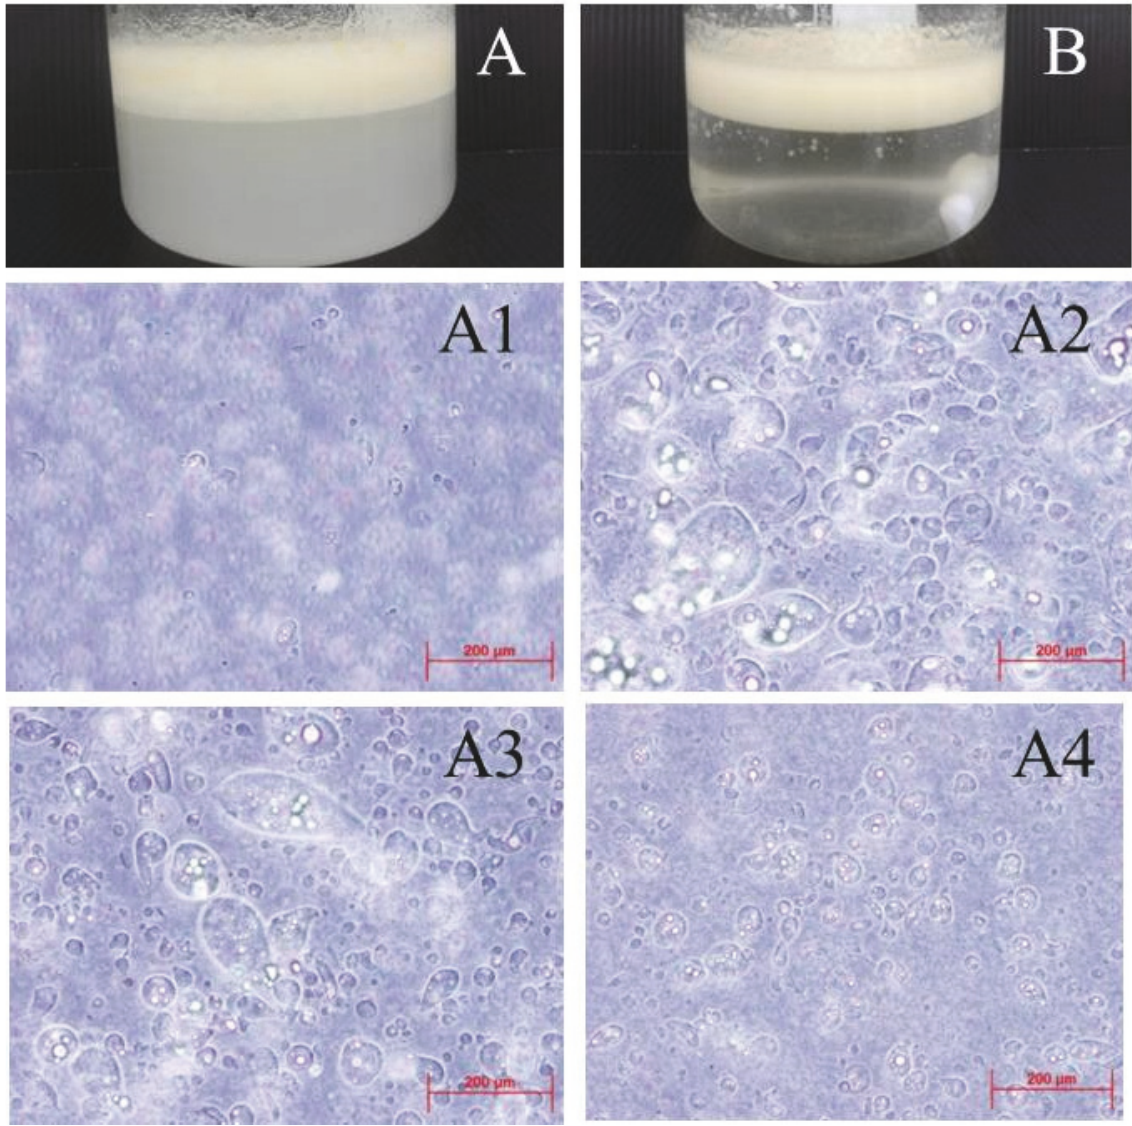
Figure 1: Microencapsulation. Prepared microcapsules with (A) Tween 80 and (B) without surfactant. The emulsion or oil layer is seen in the upperwhiteopaqueareawhilethecalciumchloridesolutionistheclearerareaundertheoillayer.Thepictureshowstheeffectonmicrocapsule morphology under microscope of (A1) 1% Tween 80, (A2) 2% Tween 80 (A3) 3% Tween 80, and (A4) 5% Tween